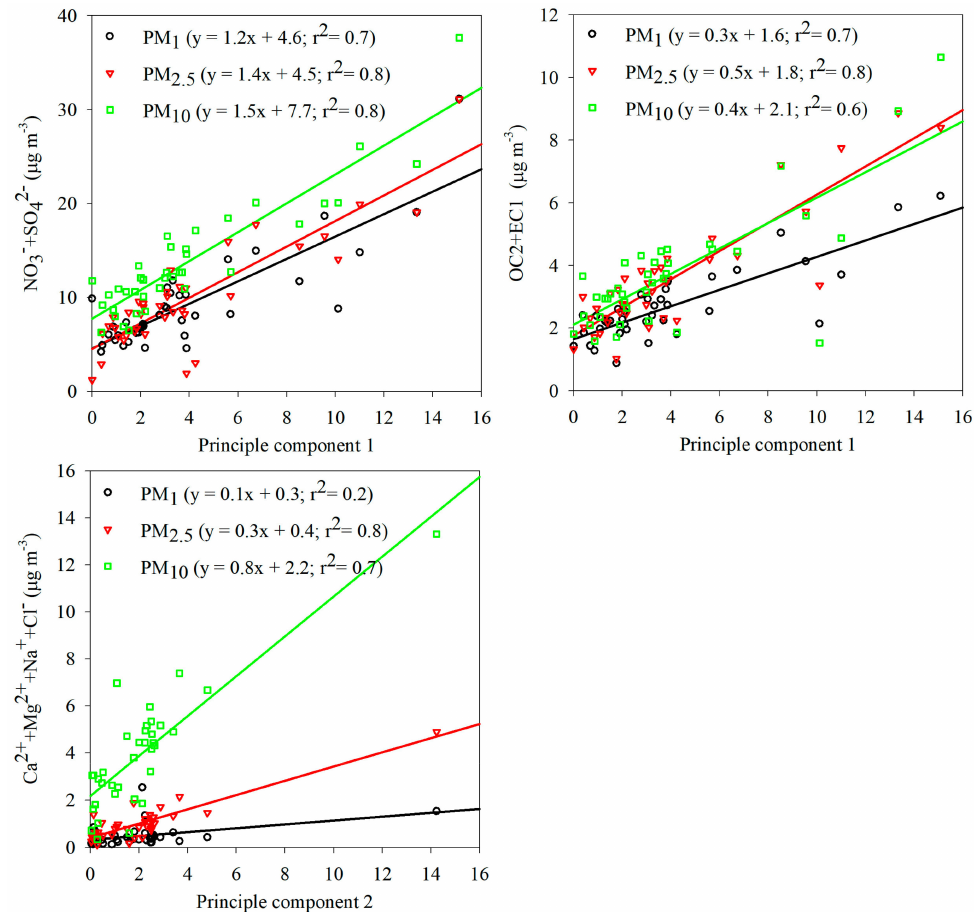
Figure 4. Correlations between the three principal component loadings and major species concentra- tions ( µ g/m 3 ) for PM 10 , PM 2.5 , and PM 1 during August 2007~February 2012.